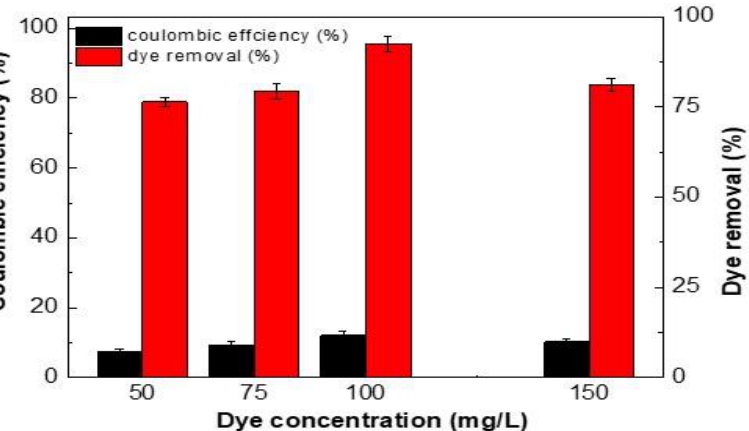
Figure 3. Initial and final absorbance of Congo red dye at different substrate concentrations and Coulombic efficiency at pH 7.